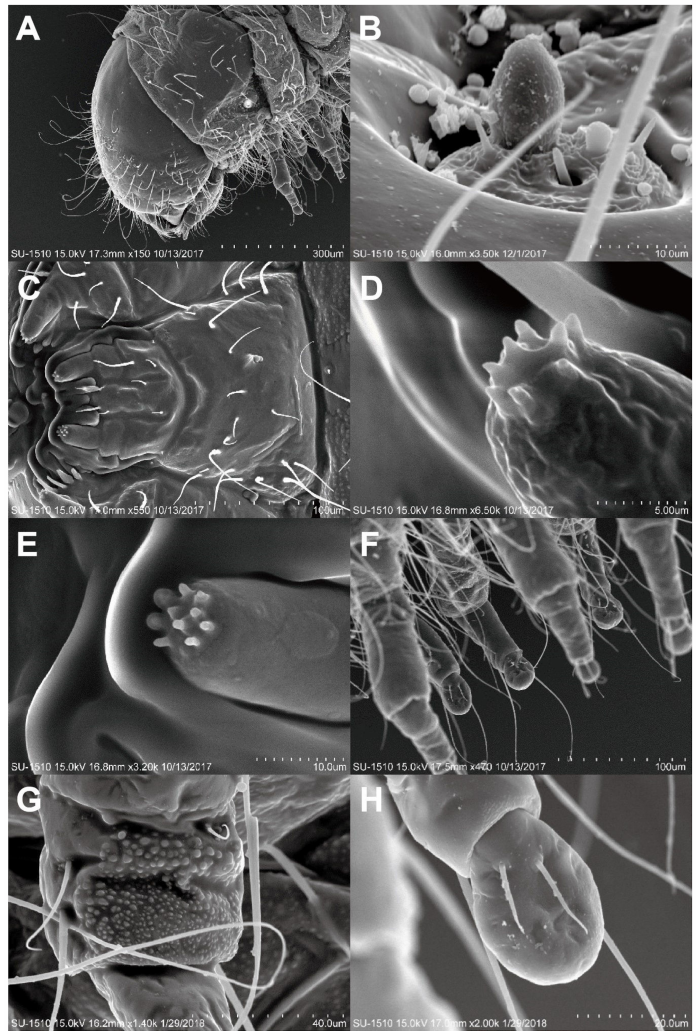
Figure 4. Last instar Larva of Falsogastrallus sauteri . ( A ) Head and thorax, lateral view. ( B ) Antennae. ( C ) Mouth part, ventral view. ( D ) Sensilla of maxillary palp. ( E ) Sensilla of labial palp. ( F ) Legs, lateral view. ( G ) Coxa, inner side. ( H ) Tarsungulus, inner side. Larva (last